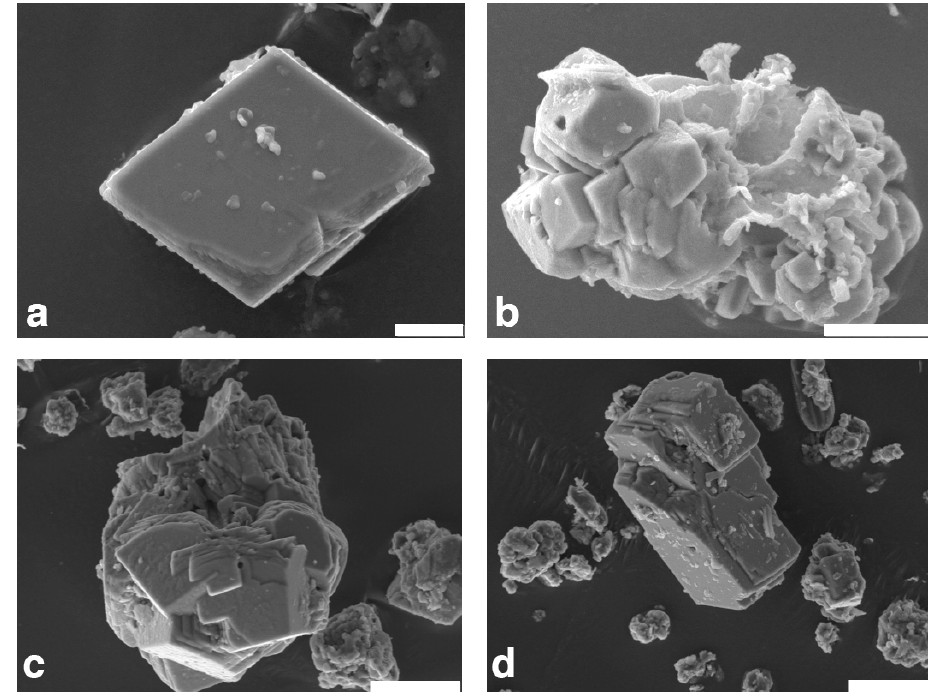
Fig. 5. SEM images from carbonate crystals: (a) authigenic calcite crystals from sediment trap 2d (mooring 2, at 6.5m depth; bar length=5µm); (b) large idiomorphic calcite crystal clusters from trap 1b (mooring 1, at 5.6m depth). Note the hole from cyanobacteria- Fig. 5: SEM images from carbonate crystals: (a) authigenic calcite crystals from 4 mediated crystallization (bar length=10µm); (c) large idiomorphic calcite crystal cluster from core 08 at 15 cm depth, recovered ∼ 100m away from the spring zone (bar length=20µm). Note similar holes as in b); (d) large idiomorphic calcite crystal clusters from core 05 at sediment trap 2d (mooring 2, at 6.5 m depth; bar length = 5 µm); (b) large 5 15cm depth recovered in the spring zone (bar idiomorphic calcite crystal clusters from trap 1b (mooring 1, at 5.6 m depth). Note the 6 hole from cyanobacteria-mediated crystallization (bar length = 10 µm); (c) large 7 idiomorphic calcite crystal cluster from core 08 at 15 cm depth, recovered ~100 m 8 away from the spring zone (bar length = 20 µm). Note similar holes as in b); (d) large 9 idiomorphic calcite crystal clusters from core 05 at 15 cm depth recovered in the 10 spring zone (bar length = 20 µm). 11